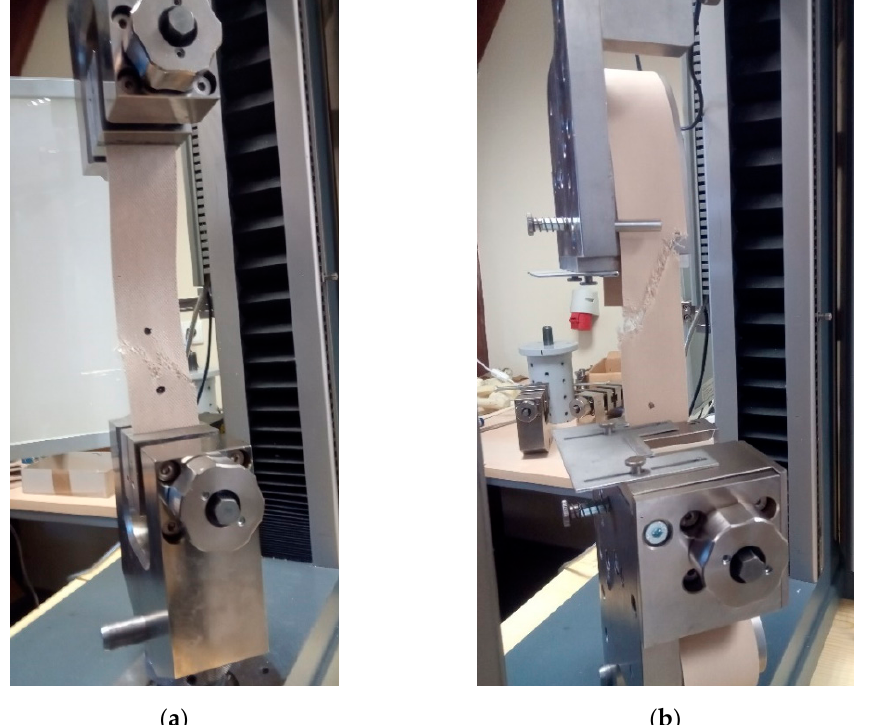
Figure 5. The typical form of specimens failure under uniaxial tensile tests: ( a ) flat grips; ( b ) curved grips.